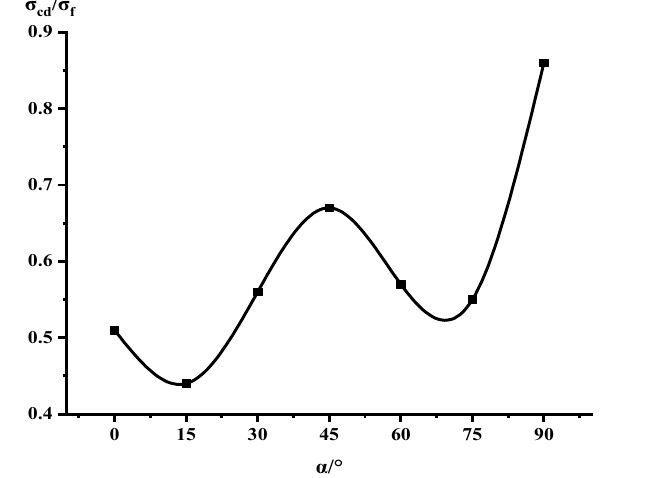
Figure 18. σ cd /σ f Curve with the dip angle of the joint.